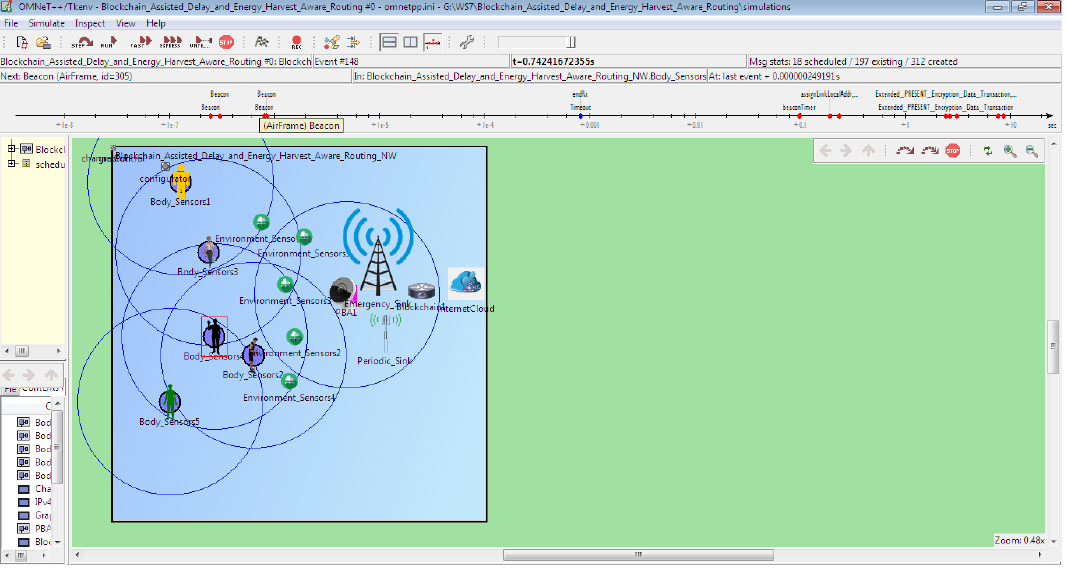
Figure 6. OMNeT++ simulation environment for multiple ban and body sensors in single ban. Table 5. Body sensors (emergency and periodical